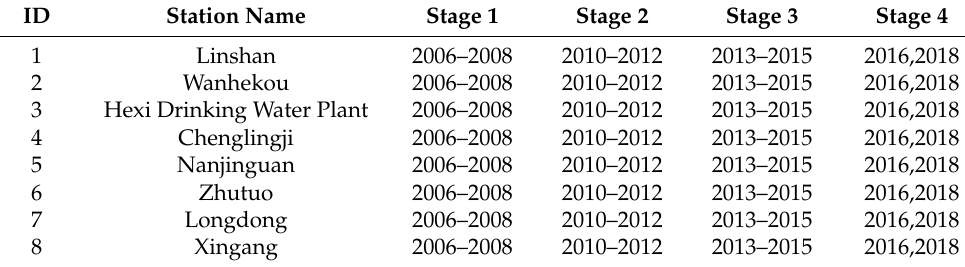
Table 2. The range of years for each